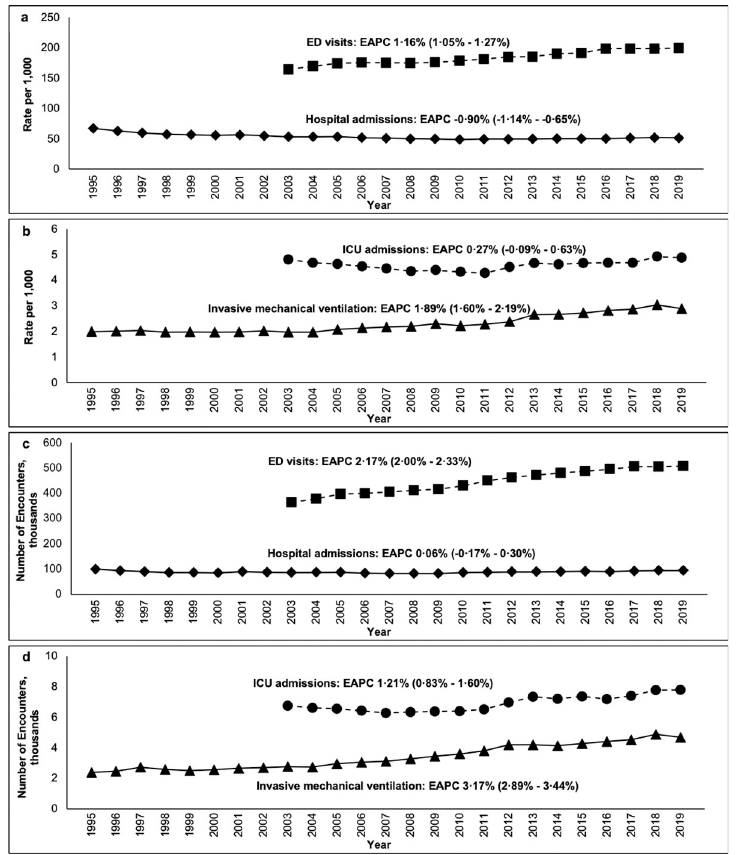
Fig 2. Secular trends in overall rates of: a) acute healthcare encounters; and b) critical care encounters, and overall volume of: c) acute healthcare encounters; and d) critical care